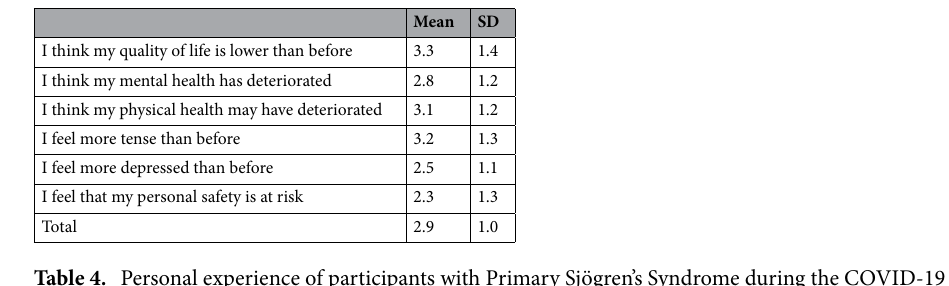
Table 4. Personal experience of participants with Primary Sjögren’s Syndrome during the COVID-19 pandemic.